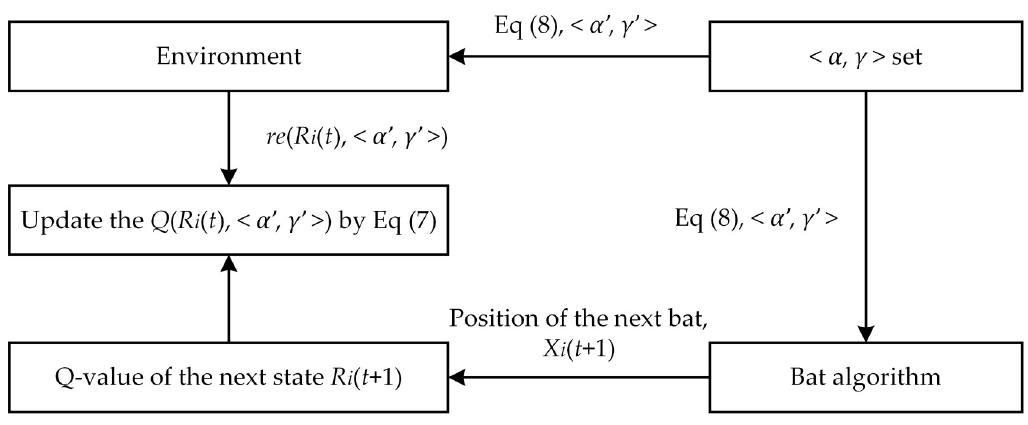
Fig 1. The combination of bat algorithm and